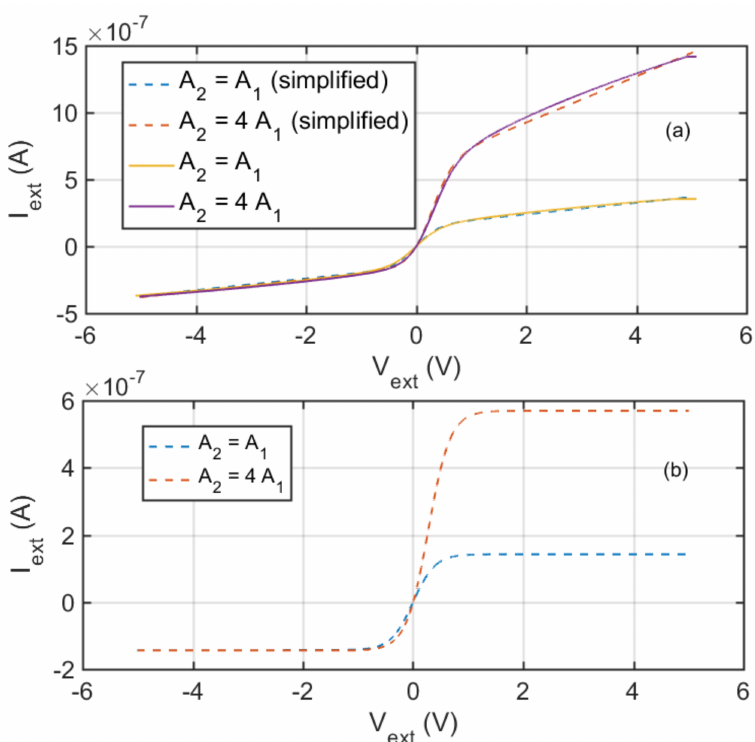
Figure 2. Static I-V characteristics. ( a ): Results obtained applying the model in Equation (1) (solid lines) and the simplified model of Equation (3) and Figure 1 (dashed lines) with the circuit parameters defined in Table 1. ( b ): Results obtained applying the simplified model of Equation (3) and Figure 1, without the resistances.